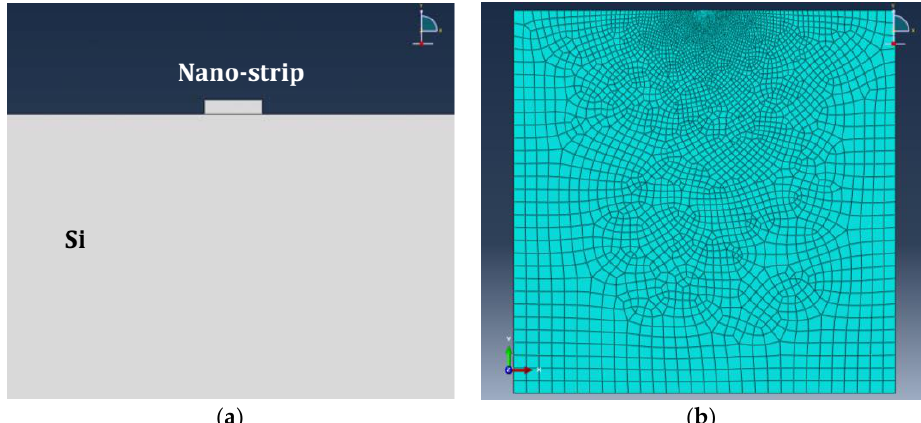
Figure 2. ( a ) Finite element model of the Au nano-strip and Si specimen, and ( b ) the corresponding mesh used in the simulation.